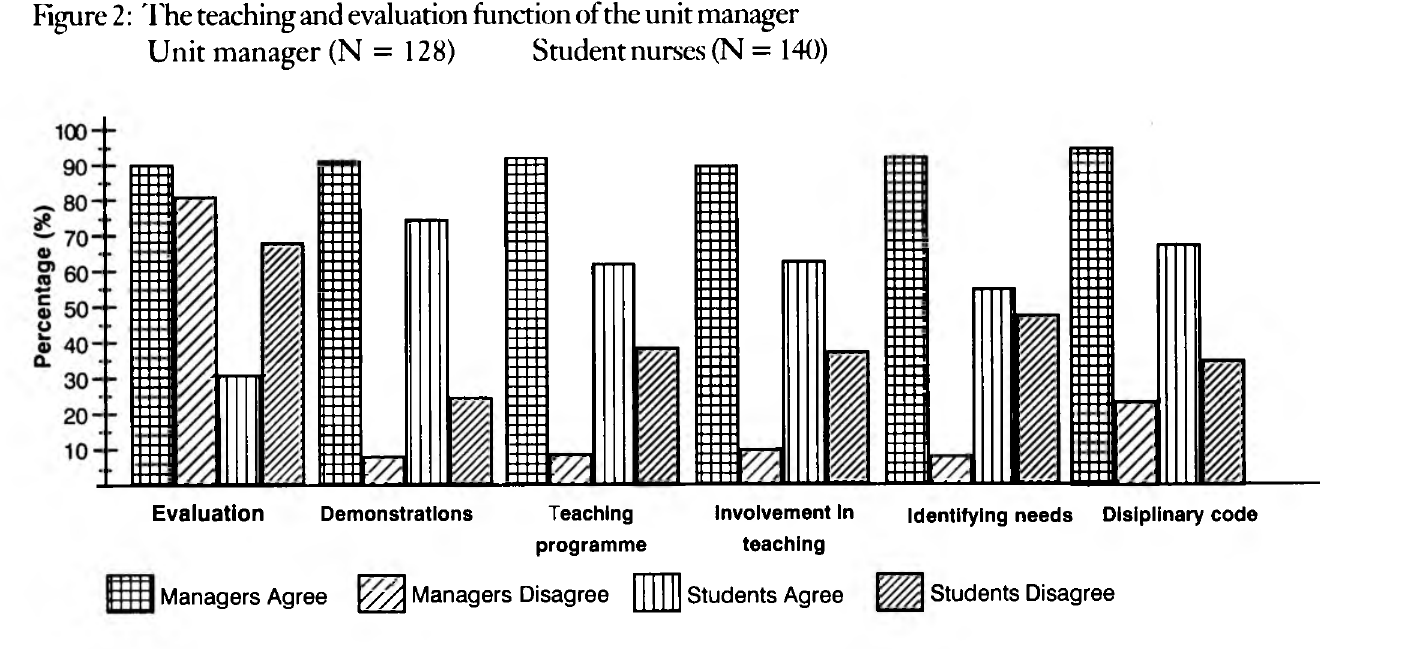
Figure 2: The teaching and evaluation function of the unit manager Unit manager (N = 128) Student nurses (N =